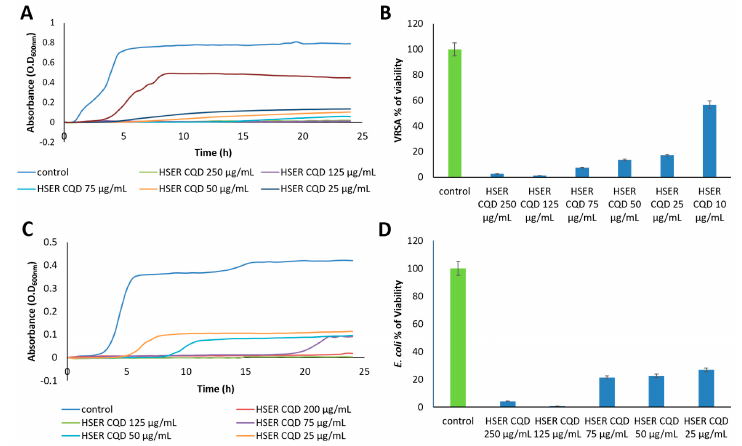
Figure 4. ( A ) The growth curve analysis of VRSA, ( B ) the viability percentage of VRSA cells, ( C ) the growth curve analysis of E. coli, and ( D ) the viability percentage of E. coli . Data represent the mean ± SD, n = 5. VRSA = Vancomycin Resistant Staphylococcus aureus